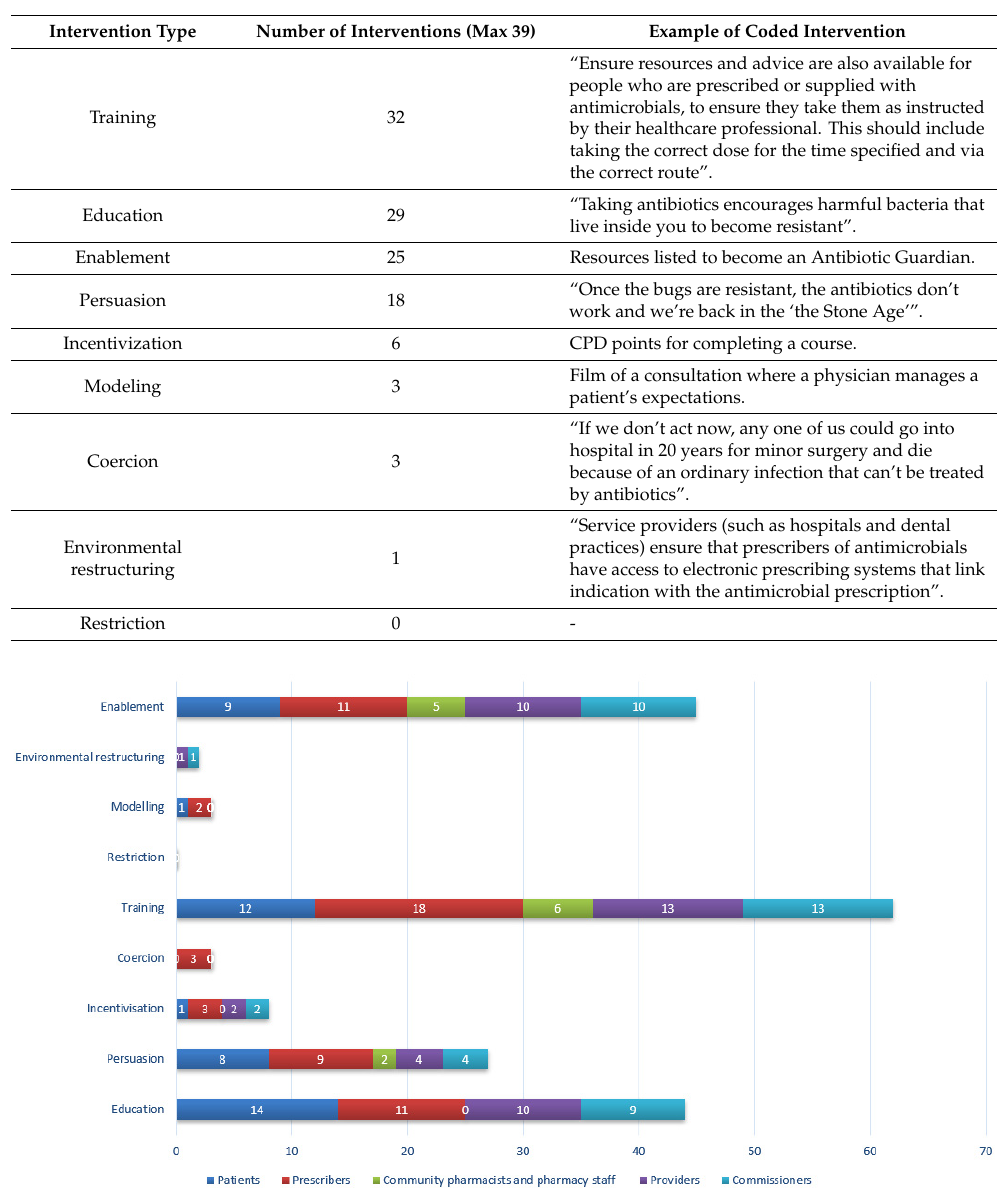
Table 4. Frequency of types in interventions.